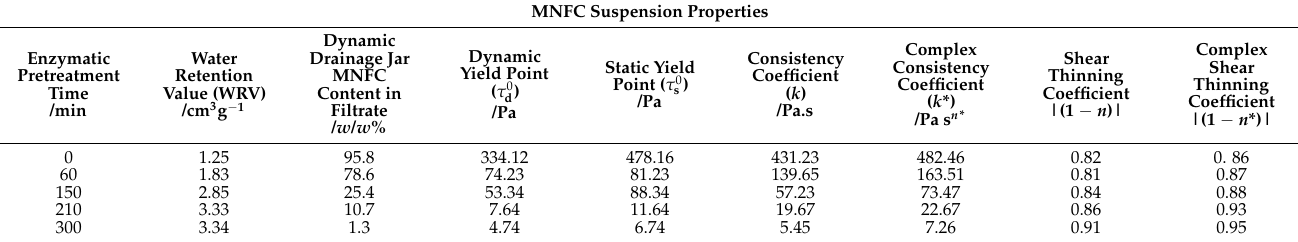
Table 2. Water retention and rheological properties of MNFC suspensions (reported as an average of five measurements within a 10%